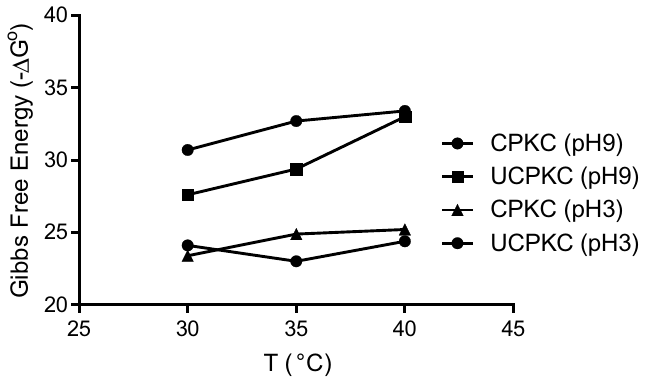
Figure 7. Plots of Gibbs free energy of adsorbents for different pH.